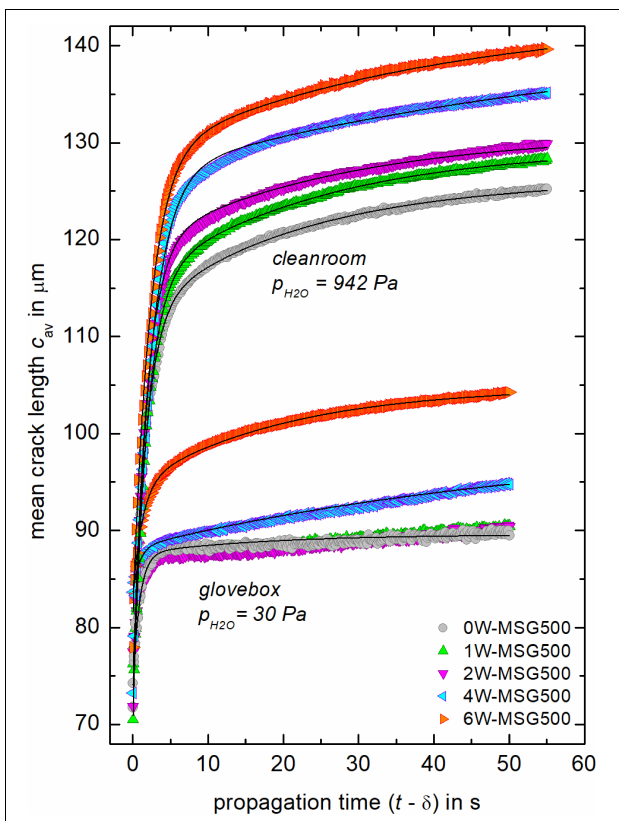
FIGURE 5 | Mean crack length c av as a function of the propagation time ( t − δ ). Solid lines are best representation of data as fitted by Equation (3) with R 2 =